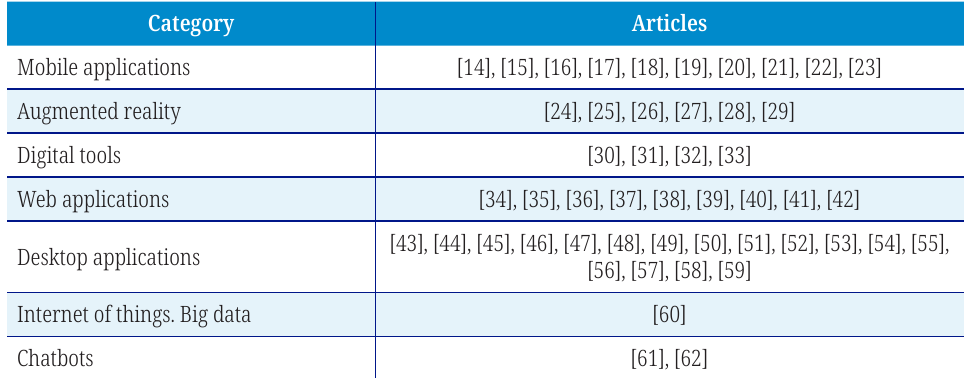
Table 2. Classification of articles according to the results